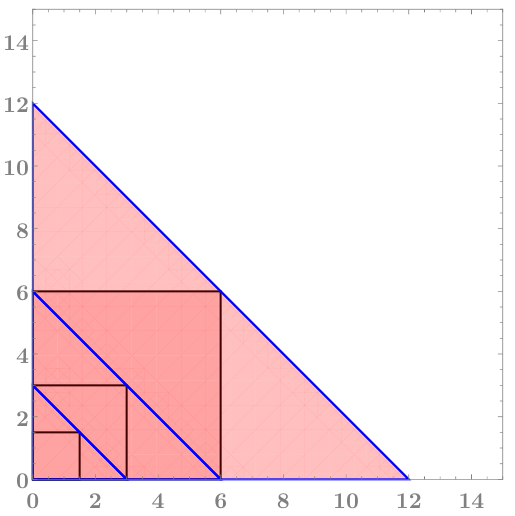
Figure 1 . Approaching to in(cid:12)nity on ( h 0 ; (cid:22) h 0 ) plane: the blue lines denote how the number of operators with ( h 0 ; (cid:22) h 0 ) is counted such that h 0 + (cid:22) h 0 (cid:20) (cid:1) and then we let (cid:1) ! 1 , this is given by